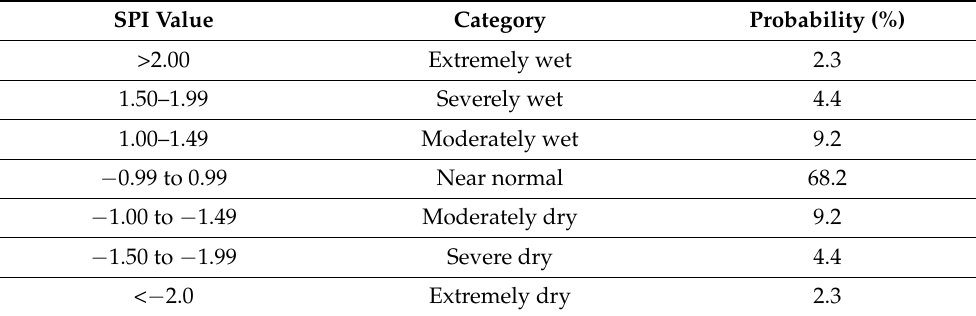
Table 3. Event Classification Based on SPI Values.